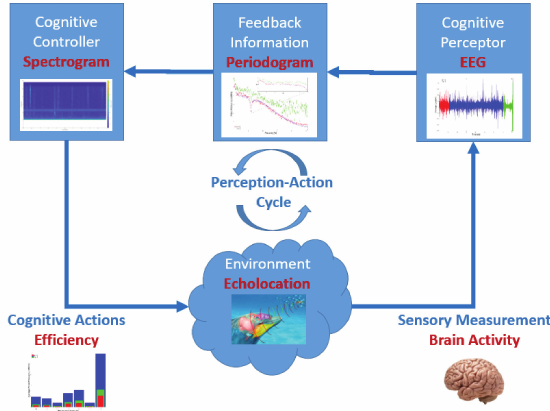
Figure 14. EEG Understanding: Cognitive Dynamic System adapted as a Global Perception-Action Cycle.